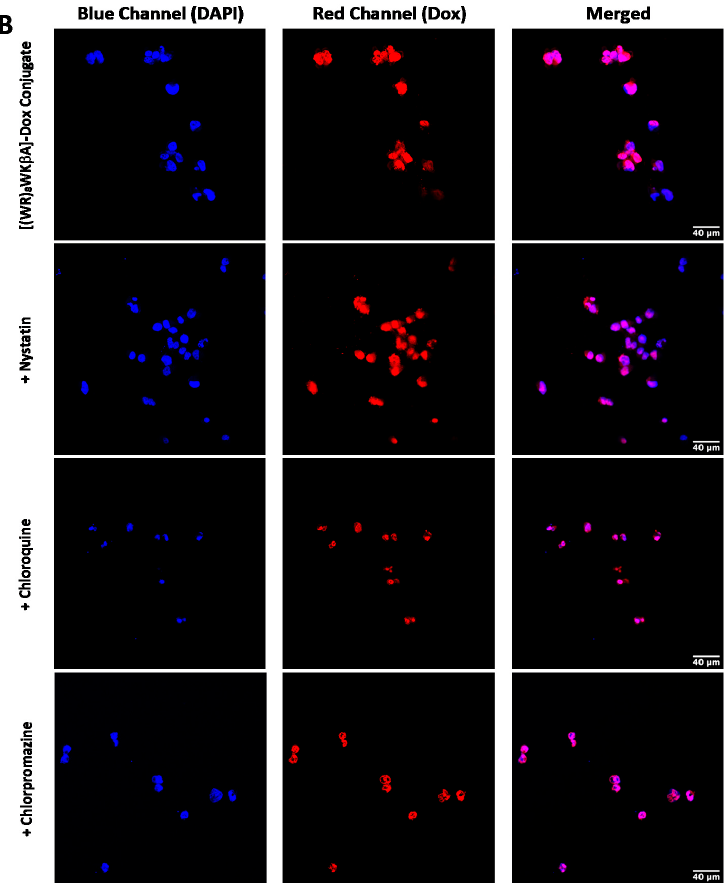
Figure 6. [(WR) 8 WK β A]-Dox conjugate (10 µM) cellular uptake in ( A ) MDA-MB-231 cells and ( B ) and MES-SA/MX2cells in the presence of different inhibitors of clathrin- and caveolae-dependent endocytosis, as studied by confocal microscopy.